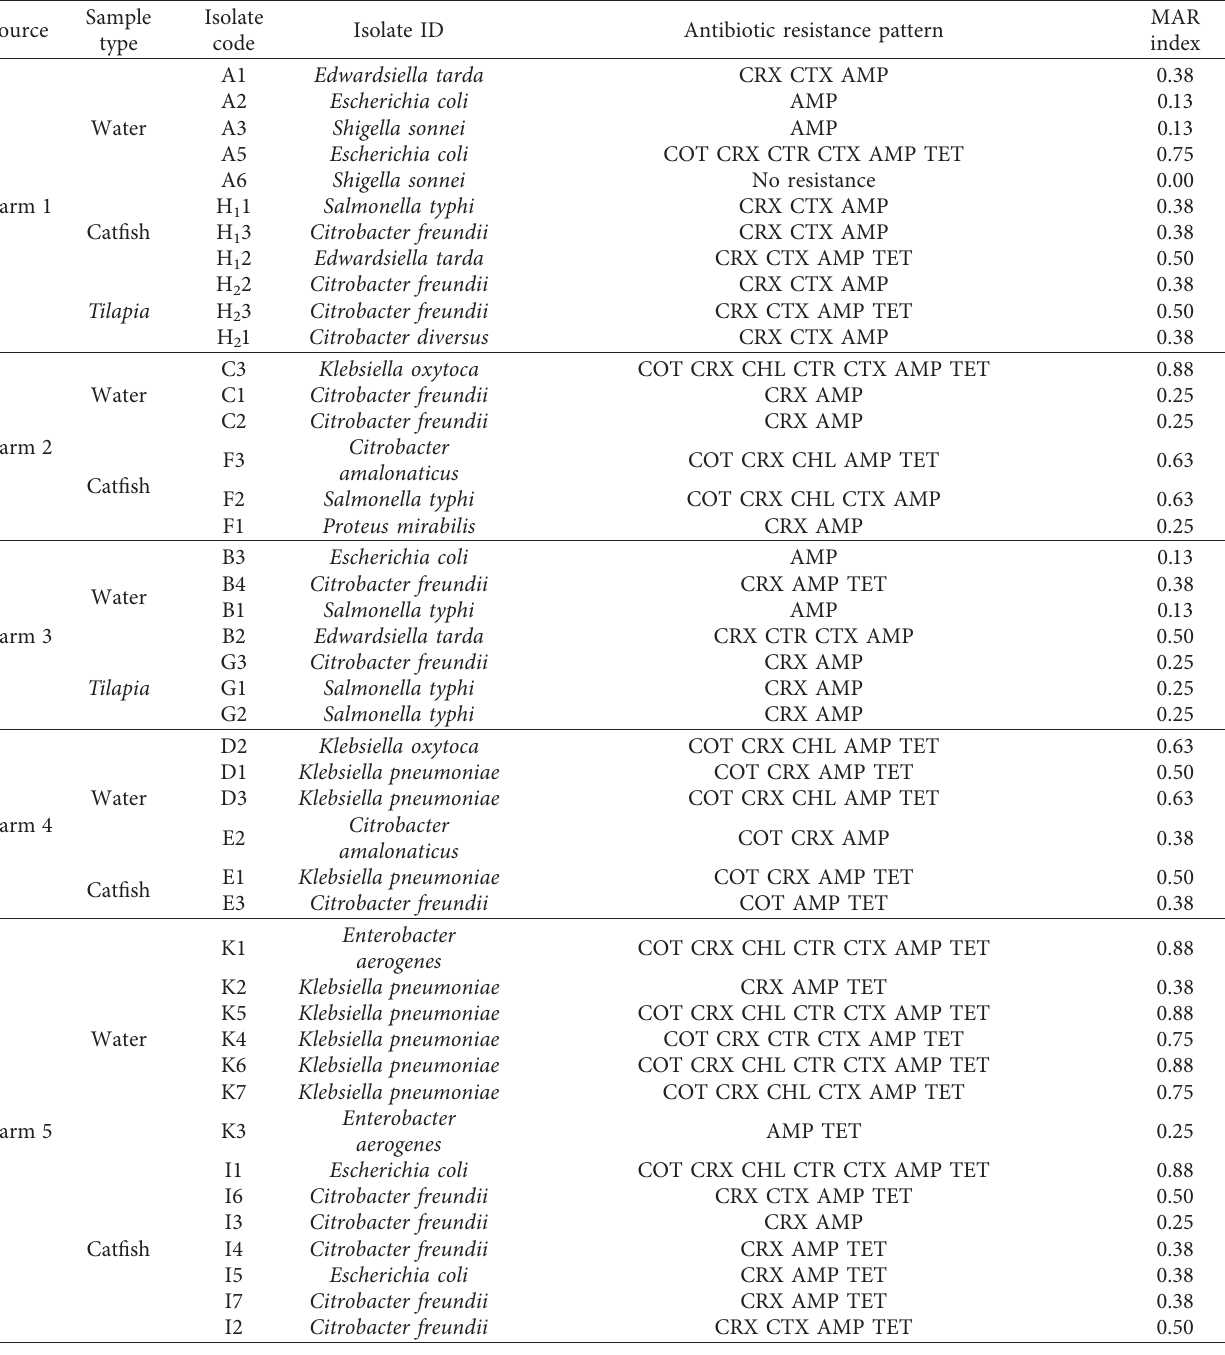
Table 4: Antibiotic resistance profile and MAR of coliforms from fish